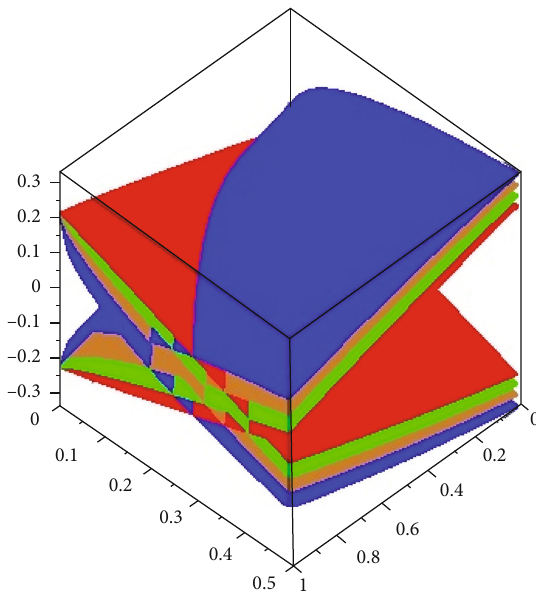
Figure 11: The fi rst graph shows the fuzzy 3D upper and lower fi gure of the various fractional orders of γ